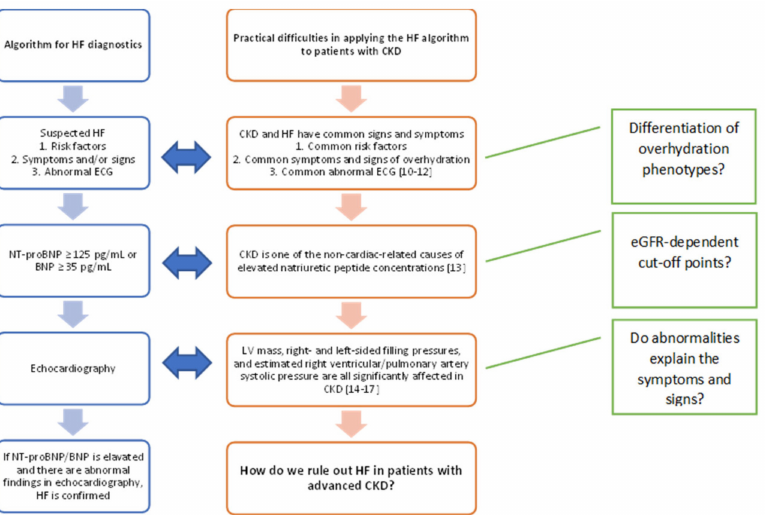
Figure 2. Difficulties in implementing the current diagnostic algorithm for HF for patients with CKD [1,10–17]. The HF diagnostic algorithm (left) includes symptoms that are common in patients with CKD, with or without HF (center). Ruling out HF in patients with CKD may require further differentiation; (right) some potential differentiation factors are proposed; For example,